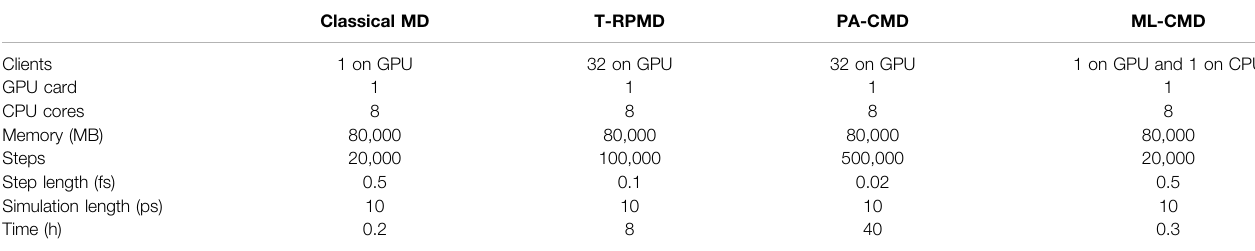
TABLE 2 | The simulate resources and time costs of different methods.